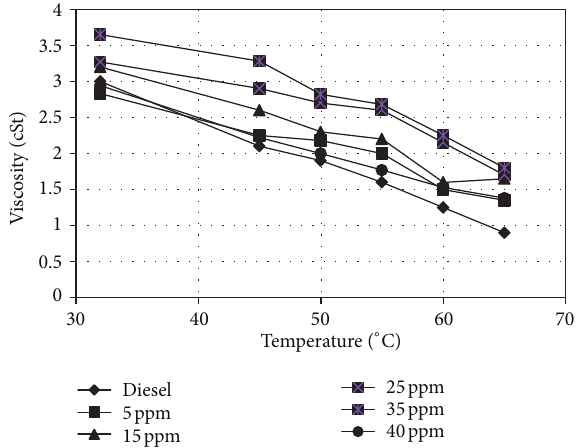
Figure 6: Variation of kinematic viscosity of diesel as a function of concentration of cerium oxide